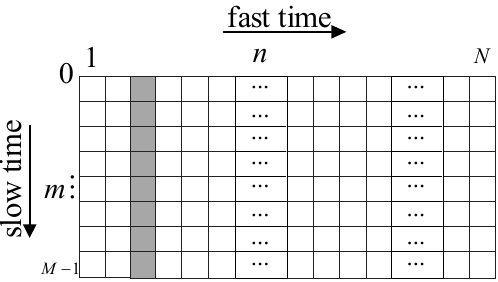
Figure 2. Two ‐ dimensional rearranged data. Figure 2. Two-dimensional rearranged